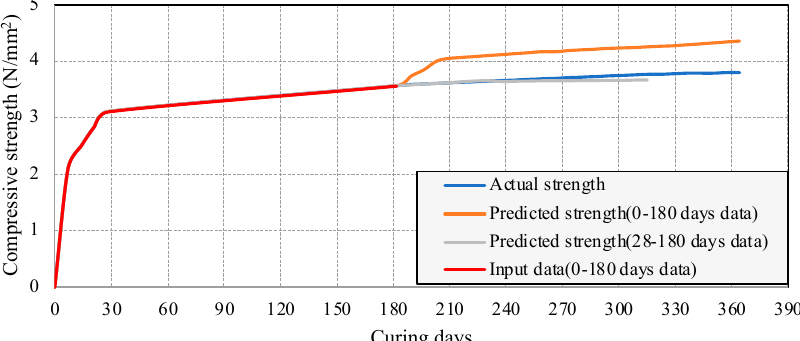
Figure 8. MLP model results for 1 year using the 180-day input data.